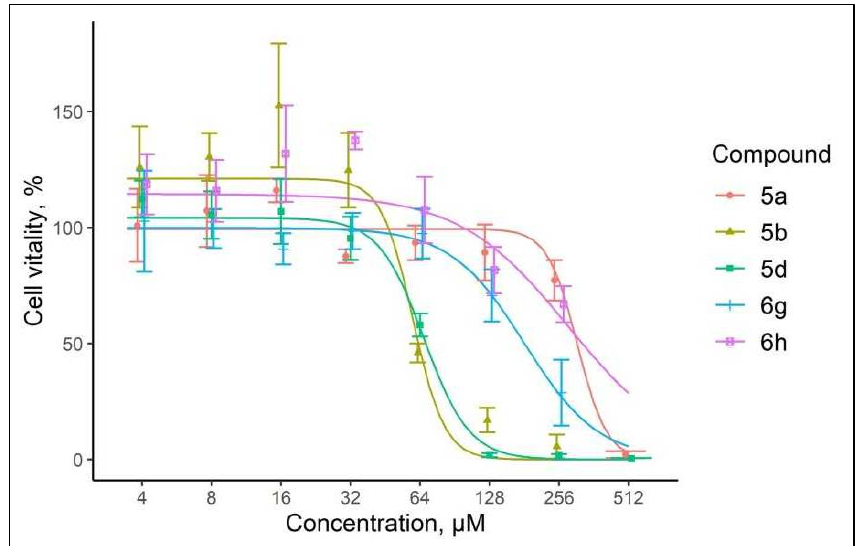
Figure 6. Dose – response curves of test compounds on human embryonic kidney cells HEK-293 Figure 6. Dose–response curves of test compounds on human embryonic kidney cells HEK-293 (mean ± SD, n = 3). (mean ± SD, n =